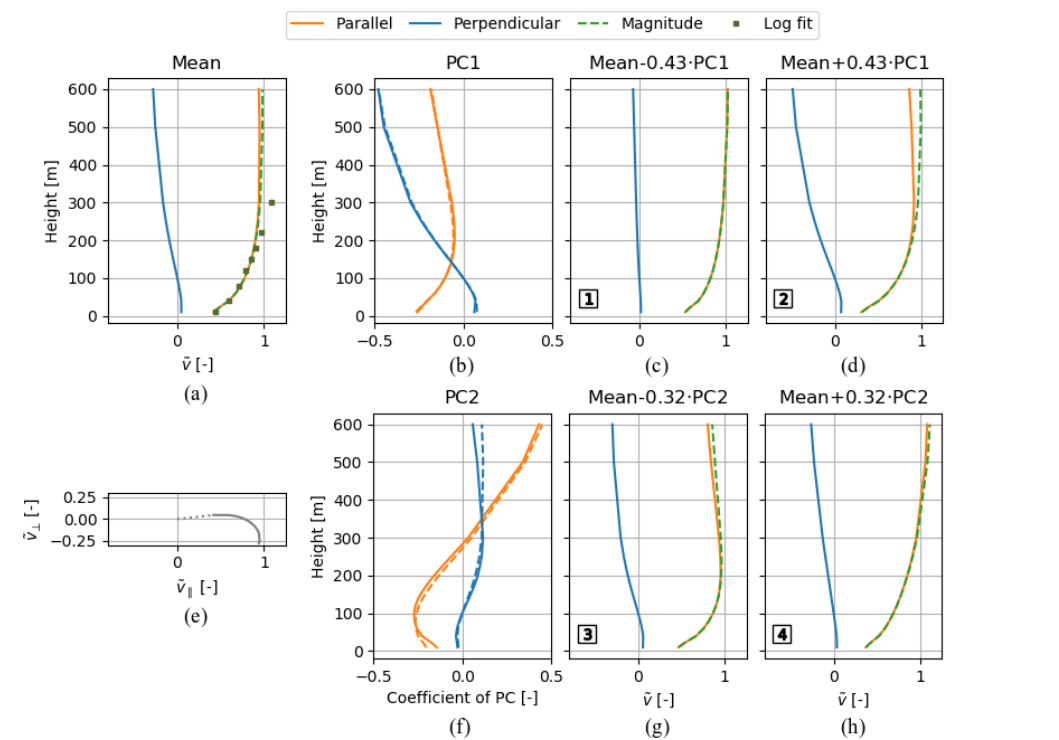
Figure 11. Mean wind profile shape and corresponding non-adiabatic logarithmic profile fit (a) and corresponding hodograph (e) for the filtered onshore dataset. Composition of the first and second PCs (b, f) . The average of the PC1 (PC2) profiles from the two reference locations is plotted alongside the onshore PC1 (PC2) profile using the dashed line. PC multiplicands superimposed on the mean wind profile shape using − 1 (c, g) and + 1 (d, h) standard deviation as multipliers. The wind profile shape numbers 1–4 refer to the markers in Fig.